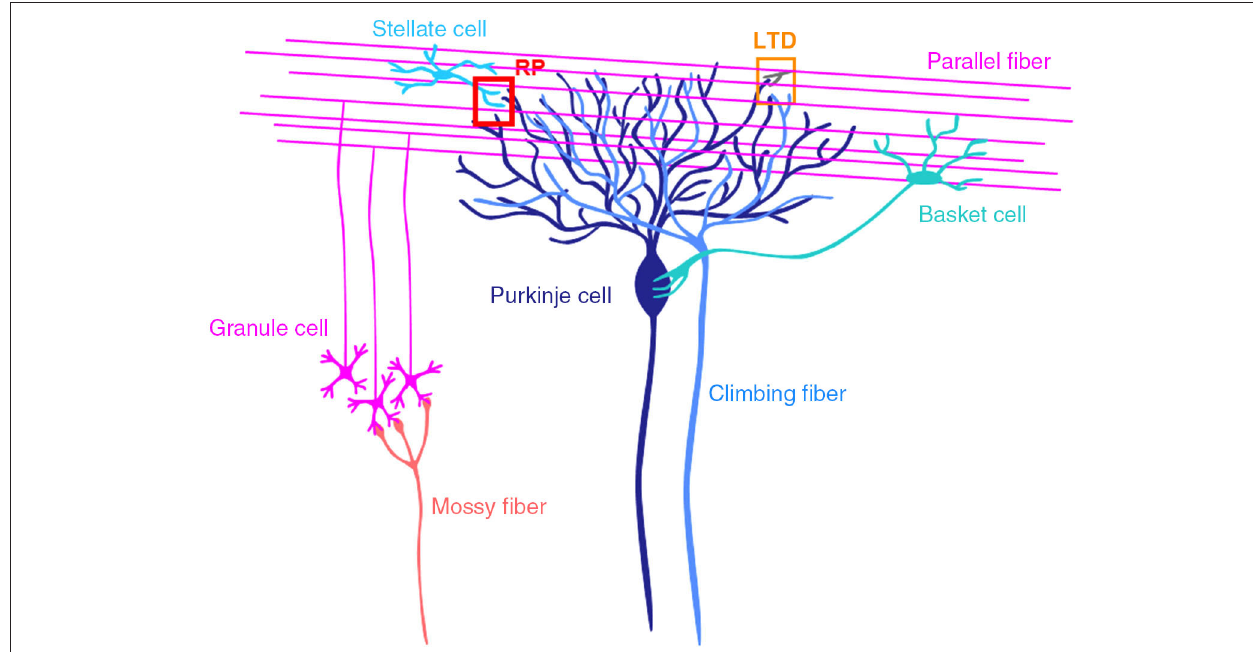
fiber. Molecular layer interneurons (stellate and basket cells) receive excitatory synaptic inputs from granule cells and inhibit Purkinje cells. At inhibitory GABAergic synapses between a stellate cell and a Purkinje cell, rebound potentiation (RP) is induced by climbing fiber activity.